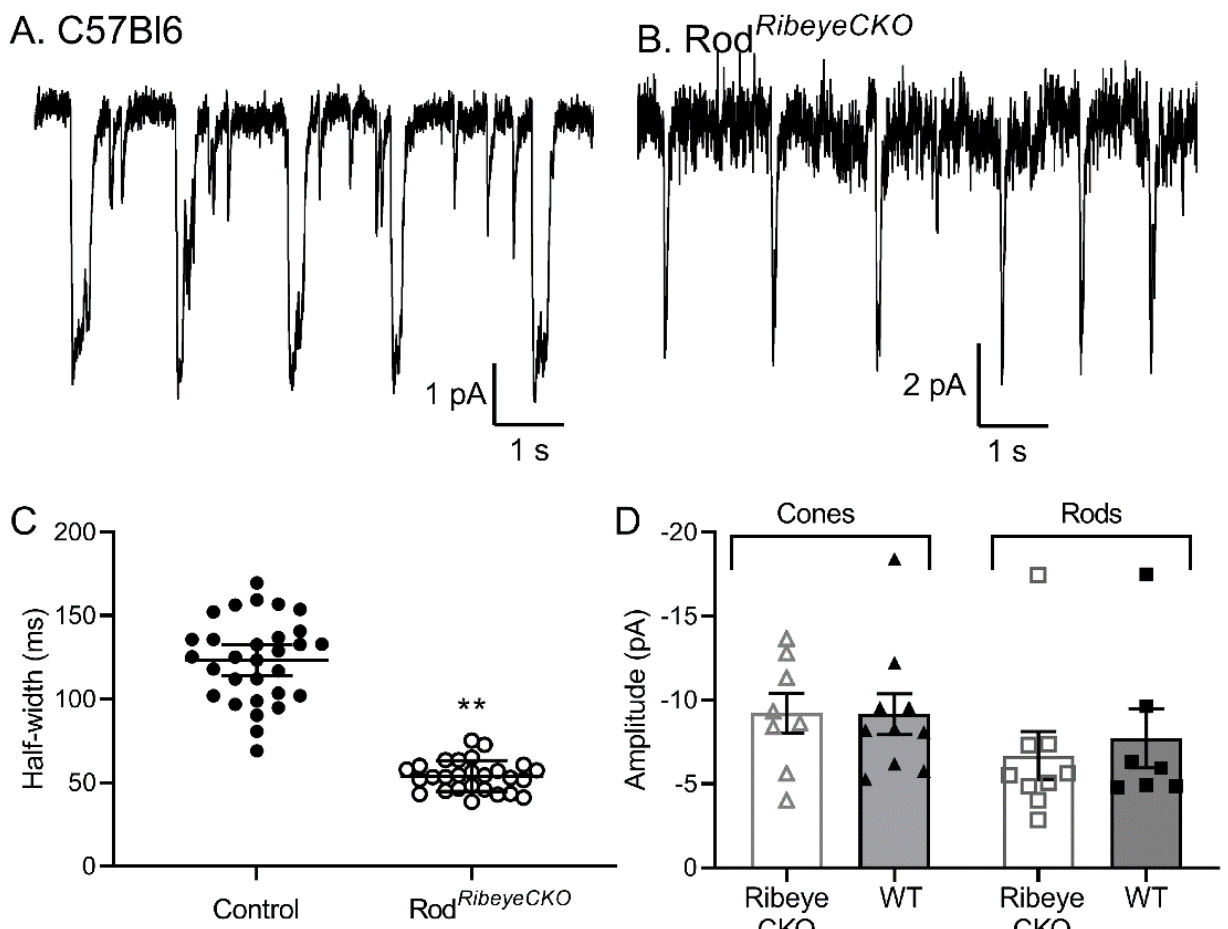
Figure 9. The duration of a periodic multiquantal release event was halved in the rod Ribeye CKO mice. ( A , B ) Examples illustrating the appearance and regularity of multiquantal release events in the mice with ( A ) and without ( B ) ribbons. ( C ) Scatter dot plot along with the means and SD of the half-widths measured from multiquantal bursts recorded at a holding potential of − 40 mV in the control and rod Ribeye CKO rods (132 ± 64 ms, n = 10 control rods, 167 events; 55 ± 26 ms, n = 5 rod Ribeye CKO rods, 98 events; **: p = 0.003, nested t -test). ( D ). Average amplitude of spontaneous I A(glu) events recorded from cones in the cone Ribeye CKO (9.22 ± 3.33 pA, n = 8 cones) and wild-type (9.16 ± 3.39 pA, n = 10) retinas and rods in the rod Ribeye CKO (6.68 ± 4.29 pA, n = 9 rods) and wild-type (7.71 ± 4.63 pA, n = 7) retinas.